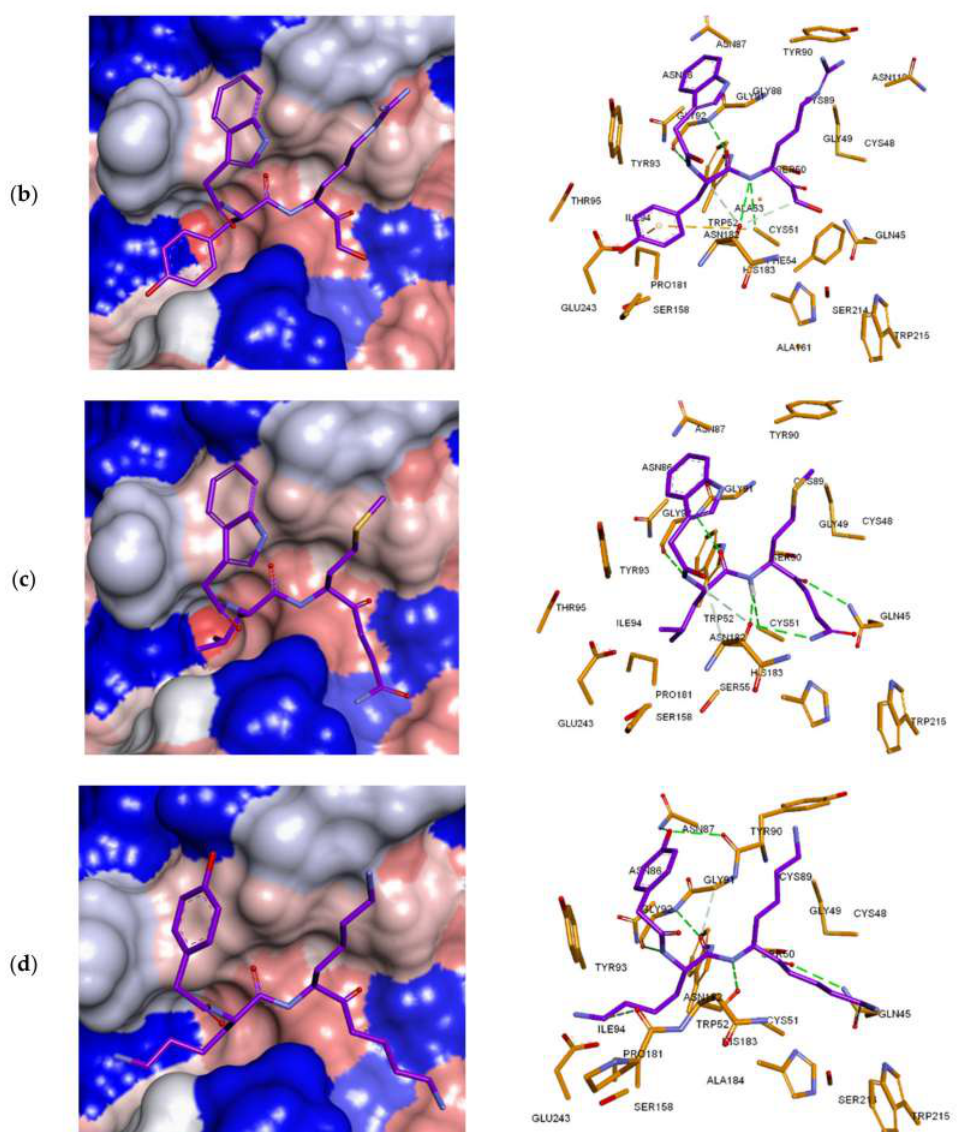
Figure 9. Connolly surfaces (left) and 3D (right) schematic interaction diagrams of the 4 most potent analogues designed at the active site of Pf FP3: ( a ) PEP-17-03-14-10 (IC pre 18-19 (IC pre = 0.19 nM); ( c ) PEP-13-06-04-19 (IC pre 50